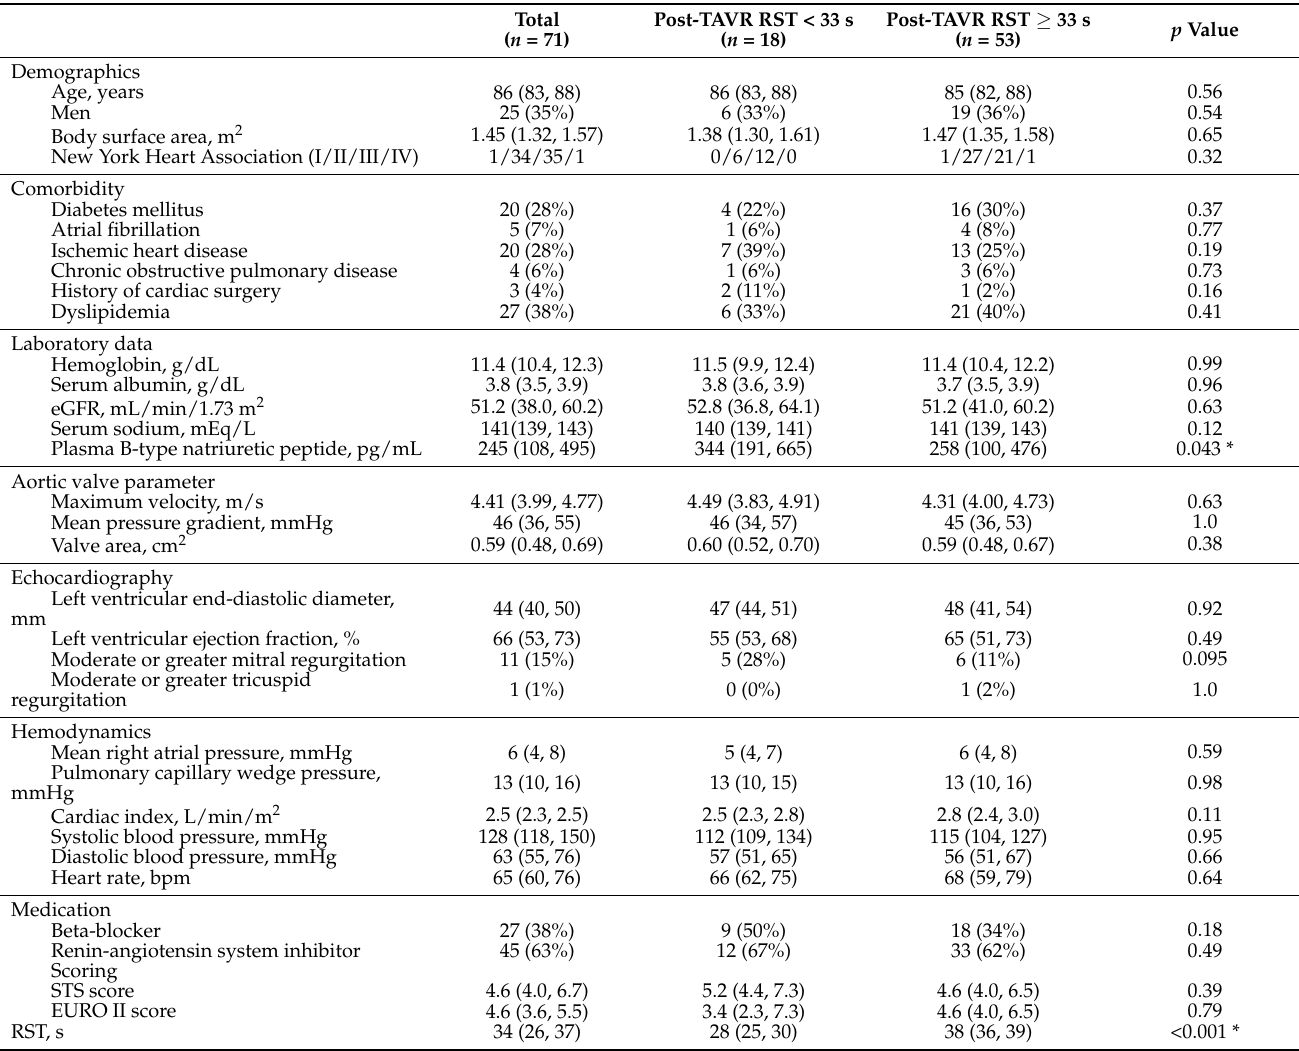
Table 1. Baseline characteristics.